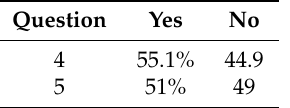
Table 2. True/False